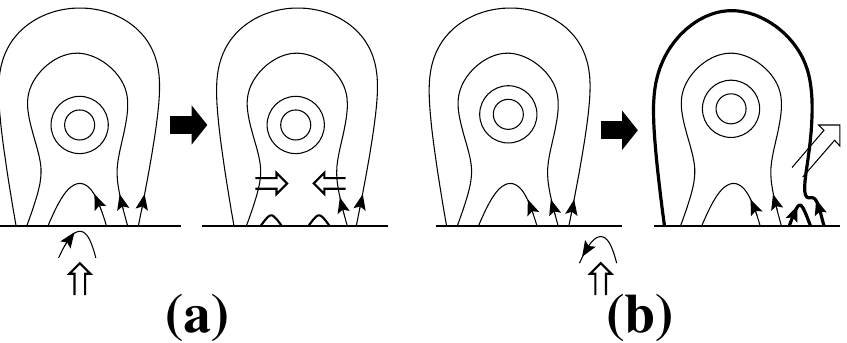
Figure 56: Schematic illustration of the trigger of flux rope eruption by reconnection-favorable emerging flux. Image reproduced with permission from Chen (2008), copyright by the Indian Academy of